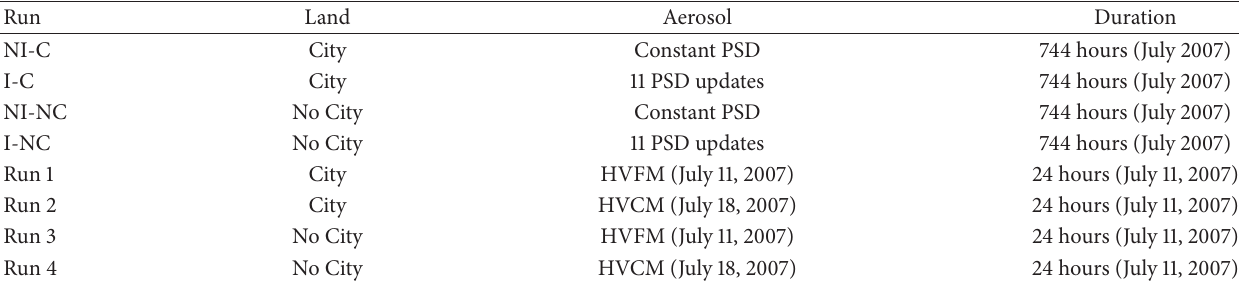
Table 1: Experimental matrix.